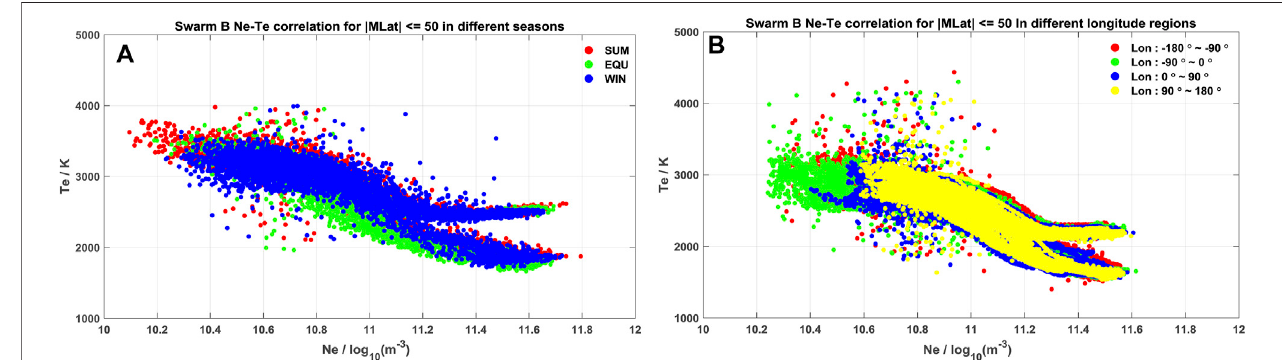
FIGURE 9 | Scatter plot of Ne and Te as measured by Swarm B. Each data point is con fi ned into within the |MLAT| ≤ 50 ° at around 14:00LT. (A) The observations during equinoxes, June solstice and December solstice are marked with green, red and blue. (B) The observations in different longitude regions including -180 ° ~ -90 ° ,